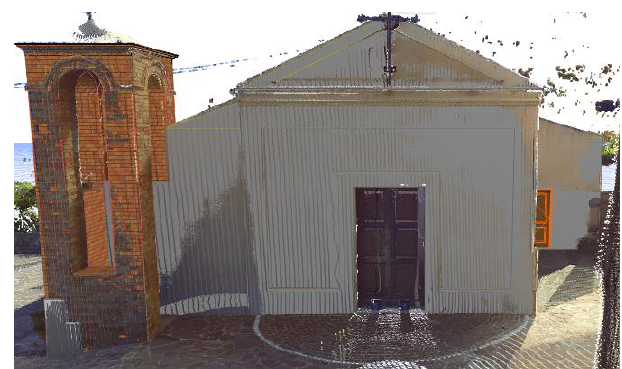
Figure 7. overlap between BIM and Dense Cloud